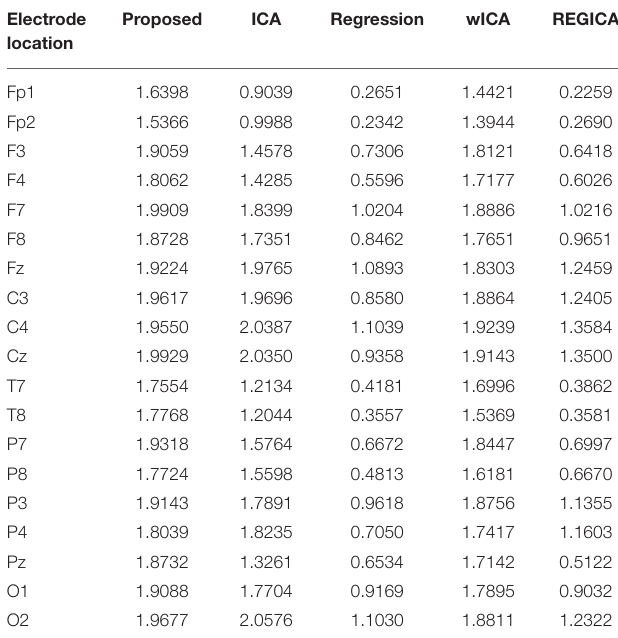
TABLE 4 | Average mutual information values results for the proposed method against conventional methods for all electrodes using simulated EEG